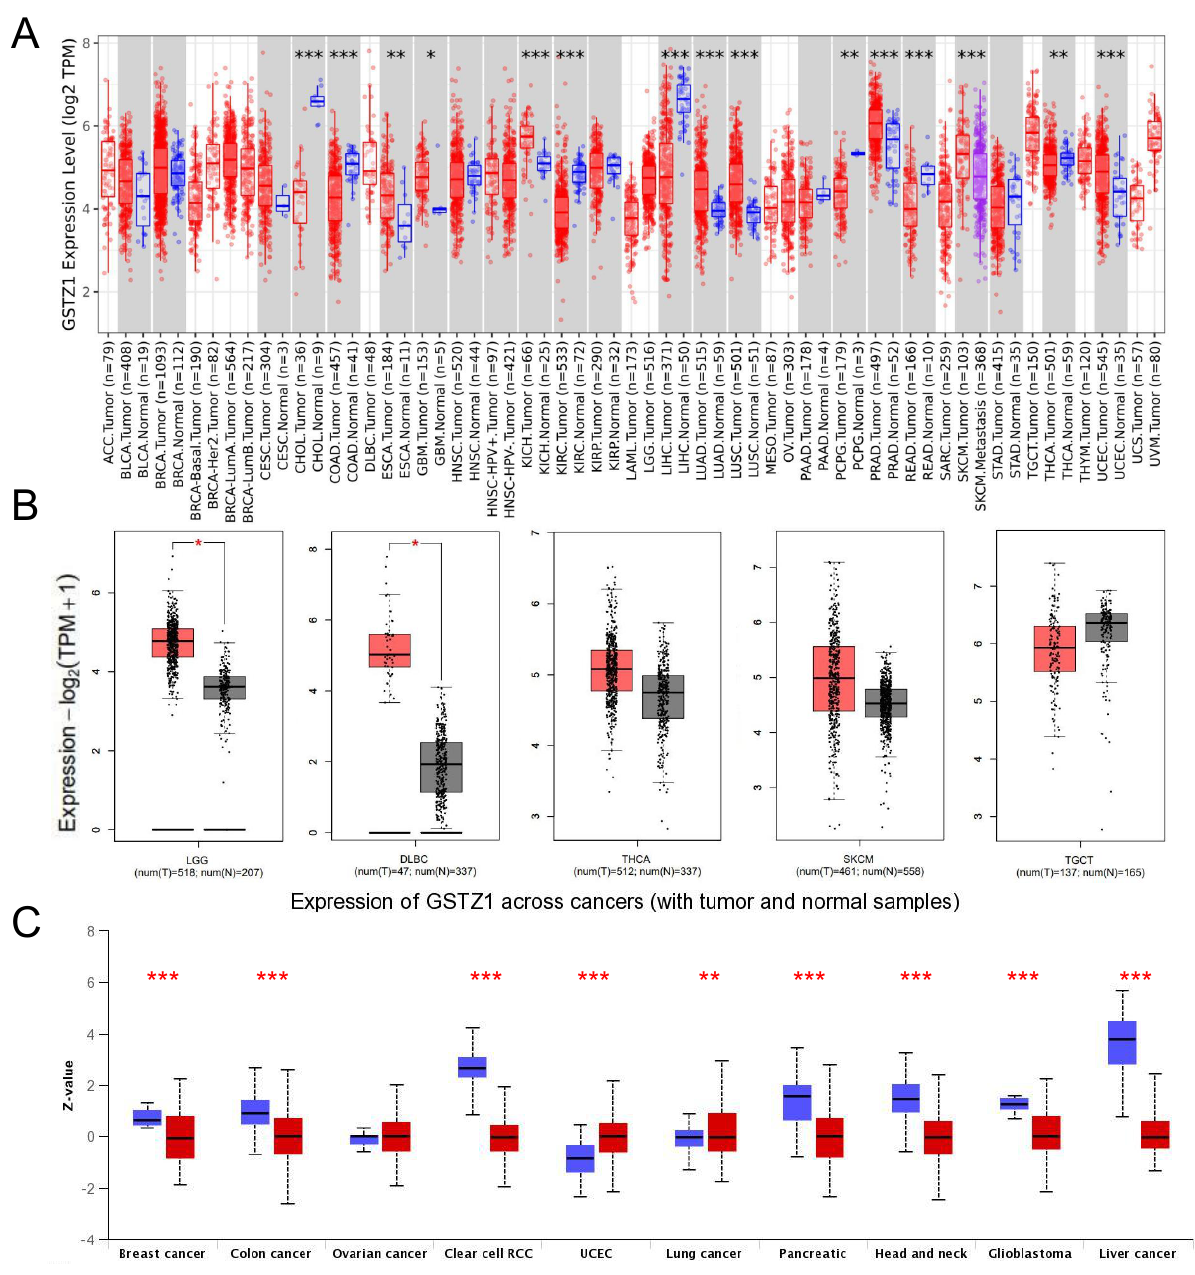
Figure 1. The chemical structures of free phytosterols, phytosterol esters, brassicasterol, campesterol Figure 1. Bioinformatics analysis of the HPGDS mRNA and protein levels in different tumors. and β -sitosterol. ( A , B ) The expression of HPGDS at the mRNA level in the noted cancer types was analyzed with TIMER2. ( C ) The expression of HPGDS at the protein level in the noted cancer types was analyzed with UALCAN, the red lines mean cancer group while the blue lines mean the normal group. * p < 0.05, ** p < 0.01, *** p <